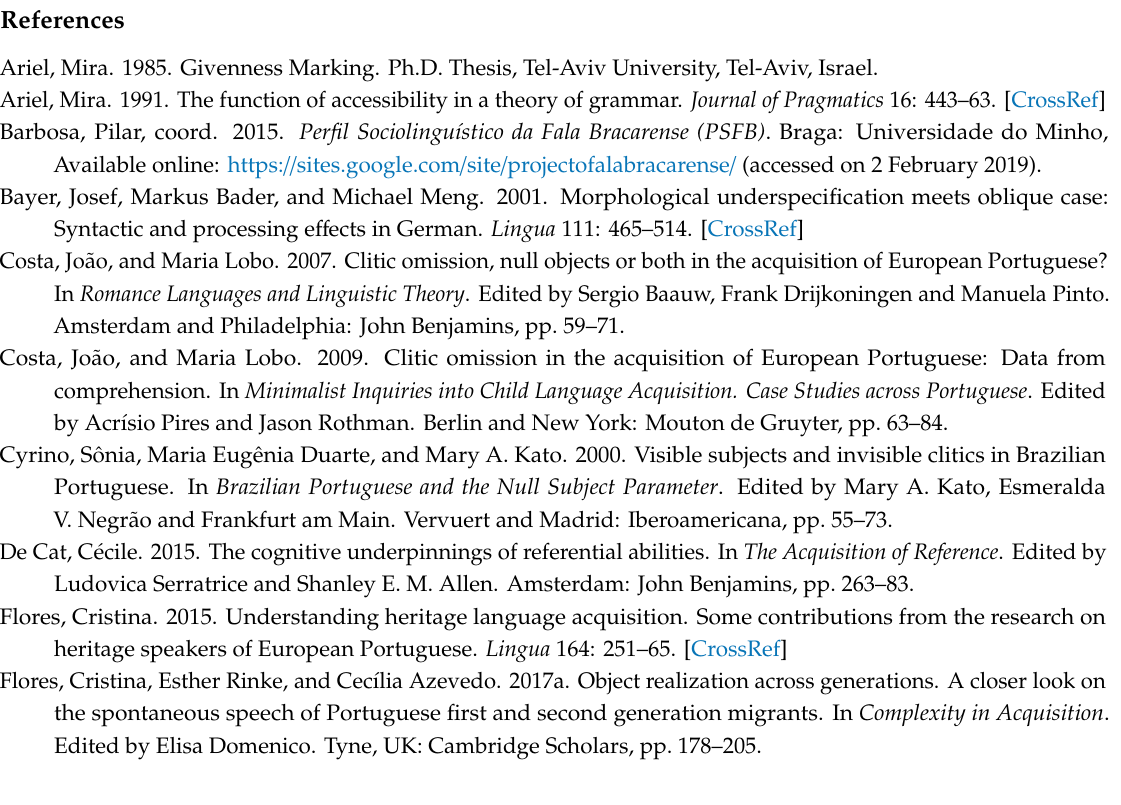
Table S1, Correlation matrix of fixed factors (EP–German bilinguals); Table S2, Correlation matrix of fixed factors (Polish–German